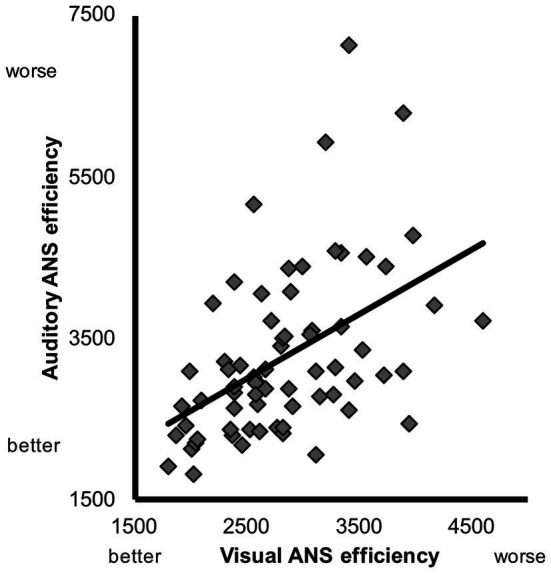
Scatterplot depicting the relation between visual and auditory ANS efficiency prior to training.